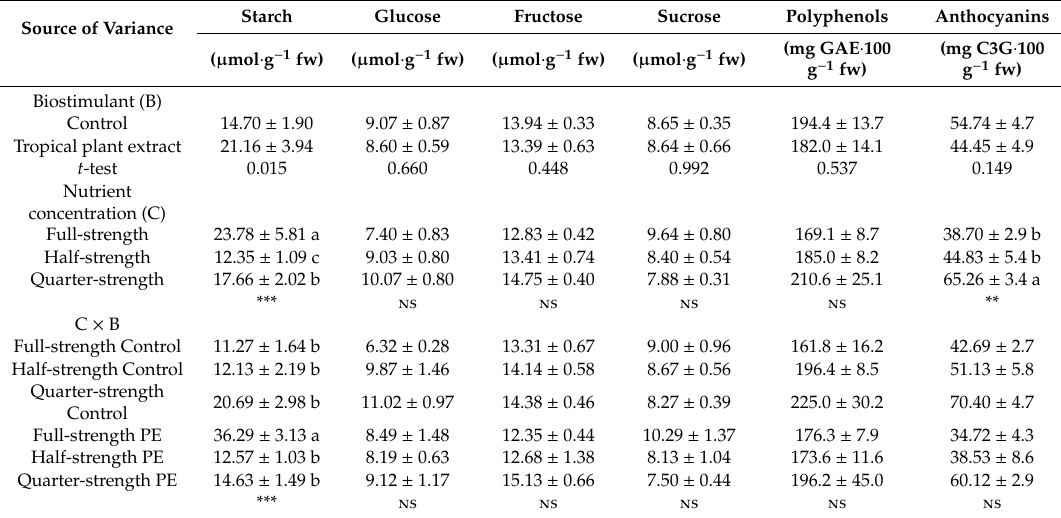
Starch, soluble carbohydrates, polyphenols, and anthocyanins contents in leaves of hydroponically grown jute in relation to nutrient solution concentration and tropical plant extract biostimulant application. All data are expressed as mean ± error, n =